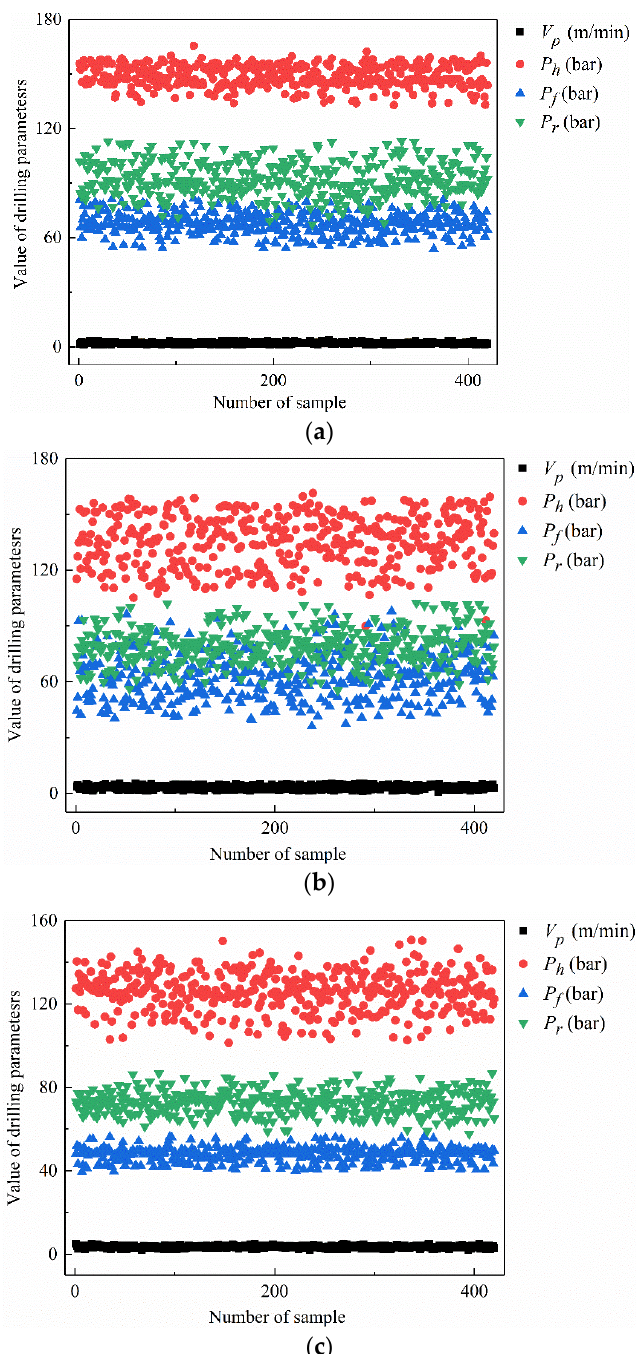
Figure 7. Scatter diagram of the data set after over-sampling (1260). ( a ) Drilling parameters of surround rock grade-III (420); ( b ) drilling parameters of surround rock grade-IV (420); ( c ) drilling parameters of surround rock grade-V (420).